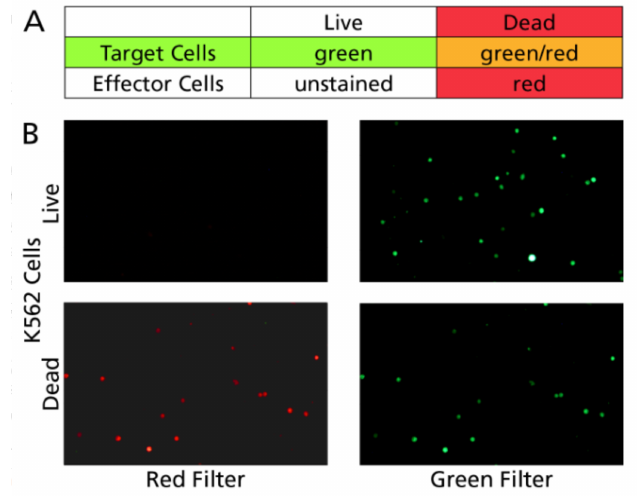
Figure 5. Principle of discriminating live and dead target cells by CFSE/PI staining. ( A ) While dead target cells retain the CFSE stain, and PI stains dead target and dead effector cells alike, only the dead target cells will become double positive. ( B ) Live target cells, when imaged, are visible in the green channel only, without cross-bleeding into the red channel. Dead target cells are positive in both, and by superimposition of the images can be automatically identified by the TVA software as double